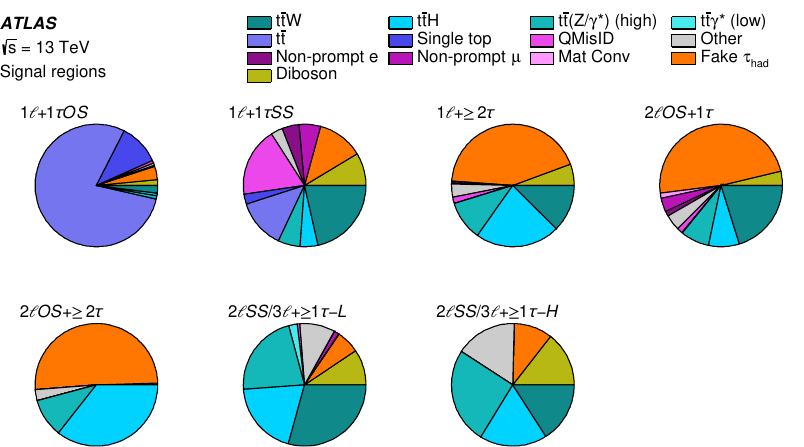
Figure 4. The fractional contributions of the various backgrounds to the total predicted background in each of the seven signal region categories (see section 5). The background estimation methods are described in section 6. The background contributions after the likelihood fit to data under the background-only hypothesis are shown (see section